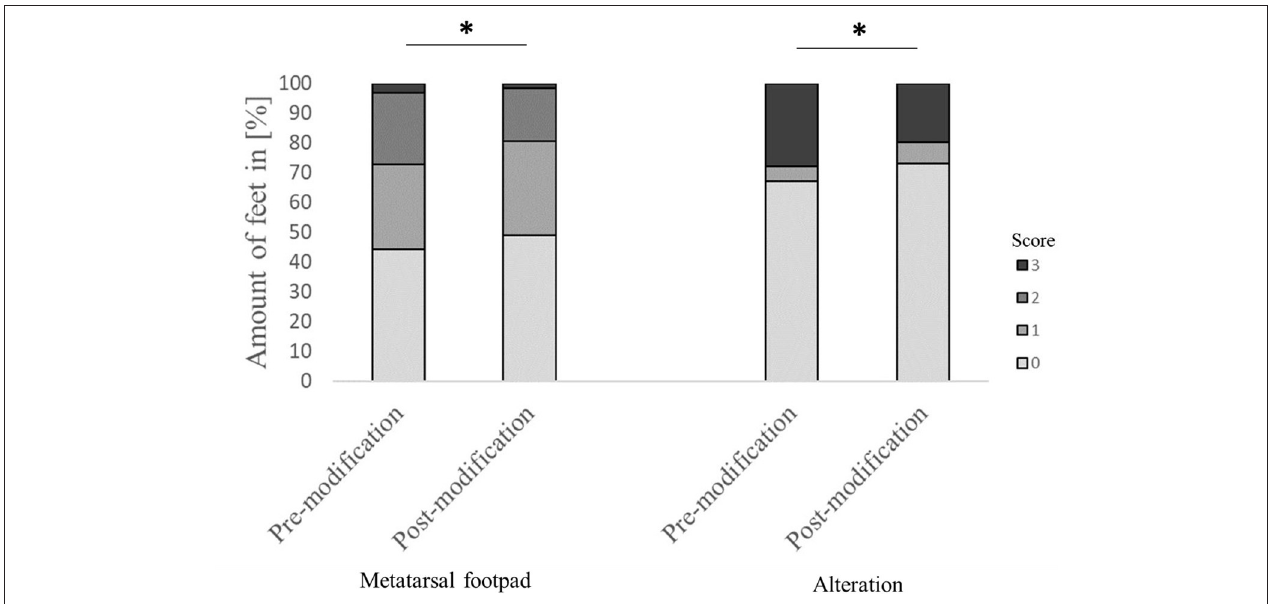
FIGURE 2 | Comparison of the performance of the automated camera system in detecting the metatarsal footpad and the alteration before and after modification of the algorithm. Data are presented as the number of feet in percent for the respective scores with increasing gray levels indicating an increasing score level (light gray = scoring level 0–dark gray scoring level 3; see Table 2 for the explanation of scoring levels); * p < 0.05; the number of feet for the detection of the metatarsal footpad: pre-modification = 2,639, post-modification = 2,505; the number of feet for the detection of the alteration: pre-modification = 2,632, post-modification =